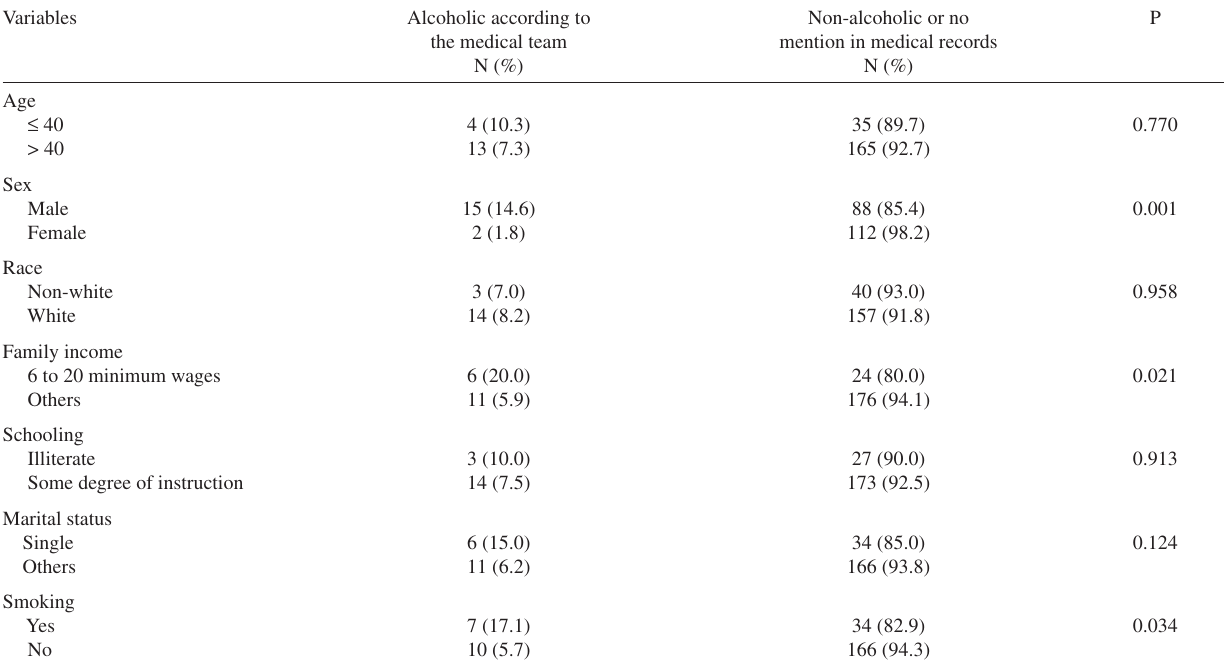
Table 2 - Identification of abusive alcohol consumption (correct or not) by the medical team and associated